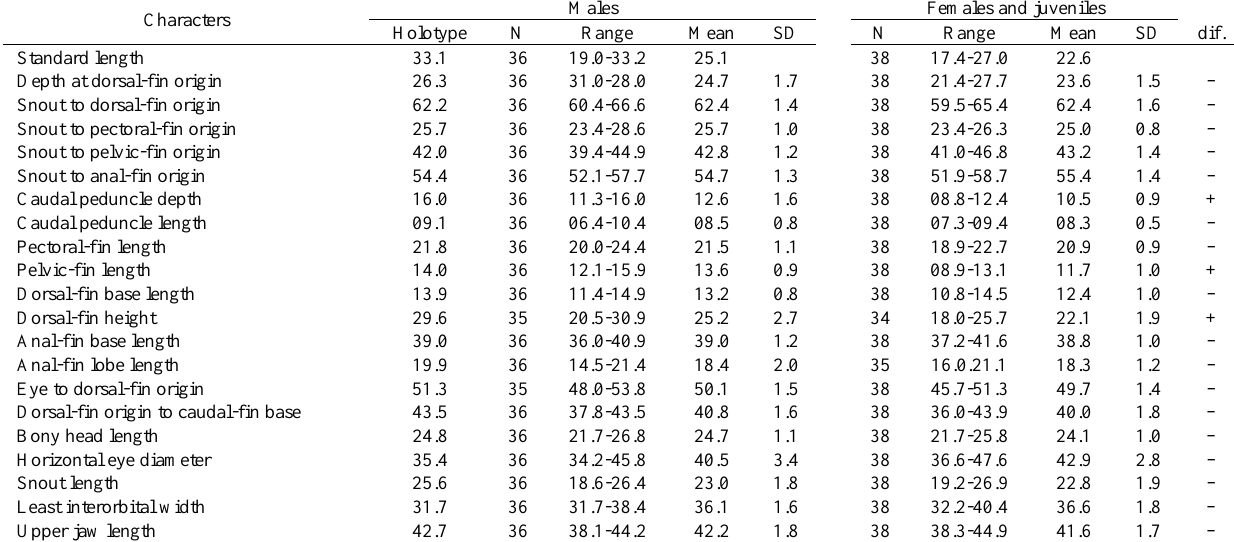
Table 7. Morphometrics of Mimagoniates barberi . Standard length is expressed in mm; measurements through bony head length are percentages of standard length; the last four entries are percentages head length. A plus sign under the abbreviation dif. indicates there is a significant statistical difference between the males and females in the particular character indicated. All specimens in this table are a combination of all localities recorded for this species: BMNH 1990.9:2 (lectotype), BMNH 1907.10.22- 6-8 (paralectotypes); USNM 179827 (paralectotypes); USNM 327586; UMMZ 205415, UMMZ 205417, UMMZ 205418, UMMZ 205420; MHNG 2241.78, MHNG 2477.61, 21-22, MHNG 2481.90, MHNG 2481.91. SD = Standard